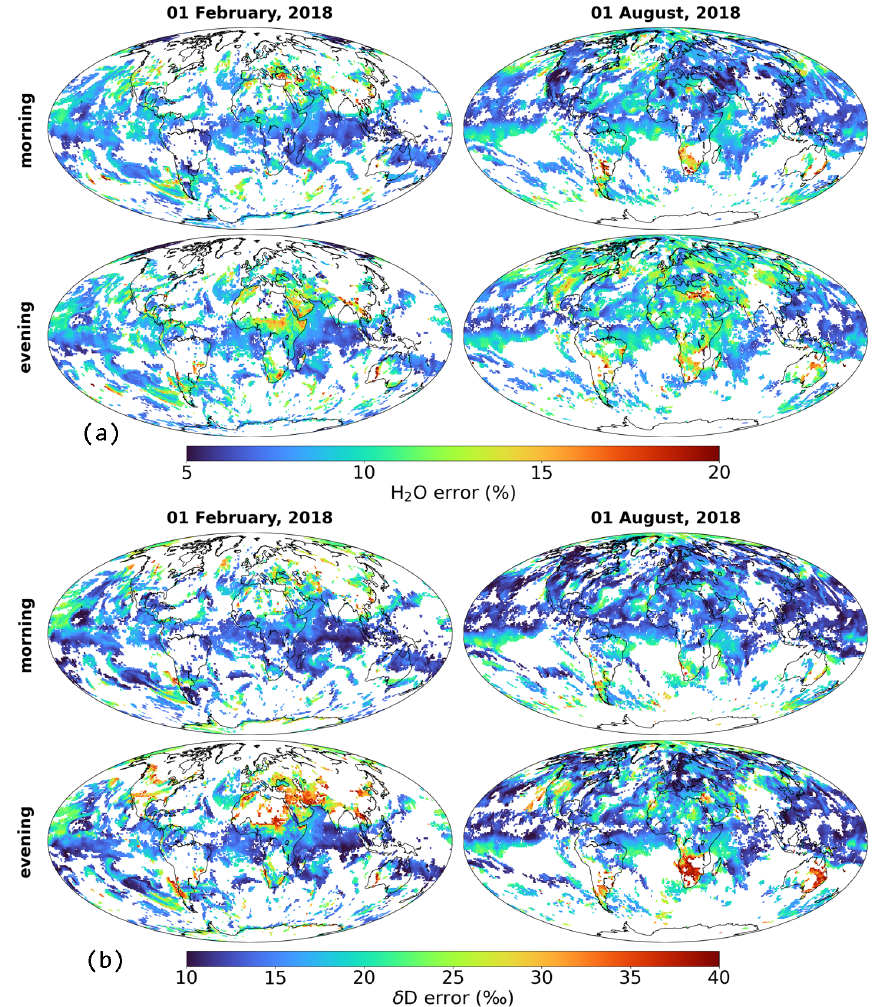
Figure 11. Distributions of the total errors of the filtered H 2 O (a) and δ D (b) product at 4.2kma . s . l . , shown for the morning and evening data of 1 February and 1 August 2018. The filtering is performed according to Table